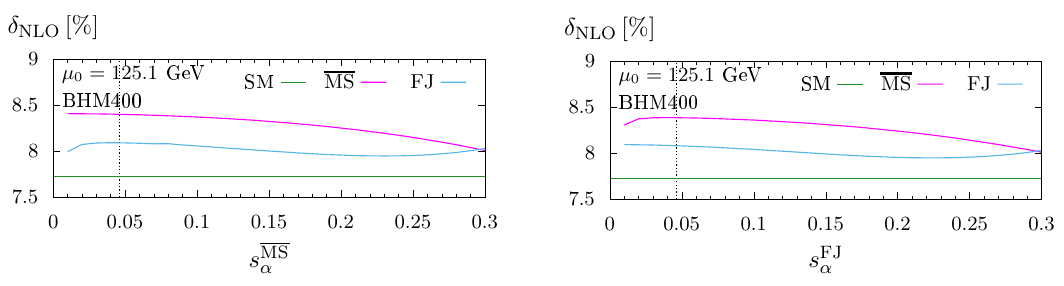
Figure 34 . As in (cid:12)gure 13, but for benchmark scenario BHM400.